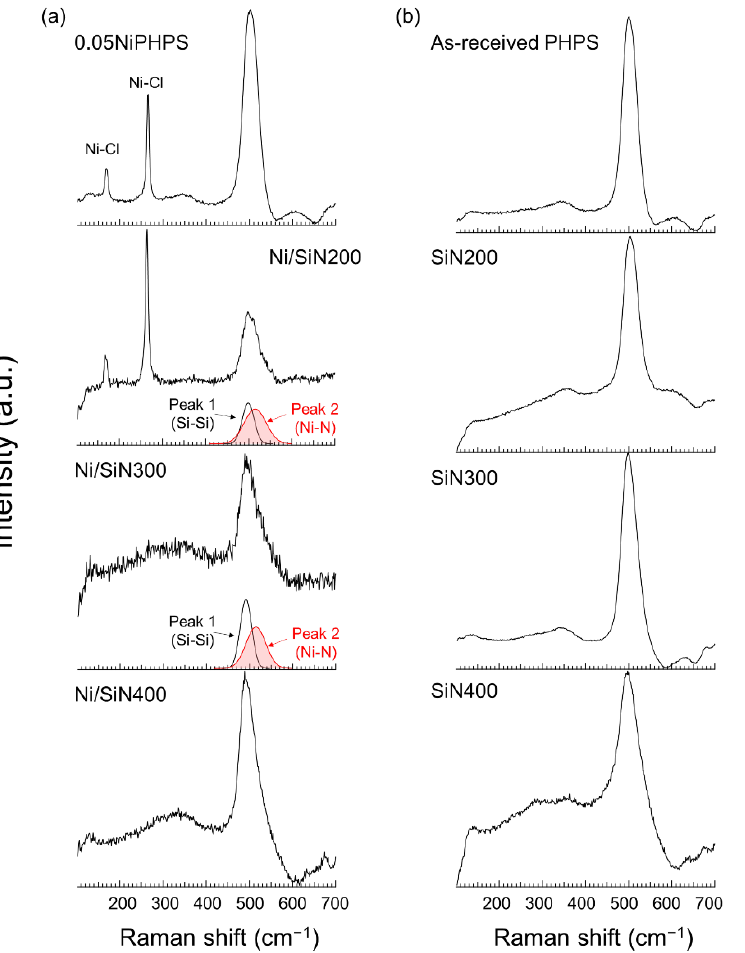
Figure 4. Raman spectra of ( a ) 0.05NiPHPS and Ni/SiNX and ( b ) as-received PHPS and SiNX samples. Deconvolution by the Gaussian curve fitting performed on the broad peak around 500 cm − 1 detected for the Ni/SiN200 and Ni/SiN300 samples yielded two peaks centered at 495 and 515 cm − 1 labeled as Peak 1 and Peak 2 , respectively.